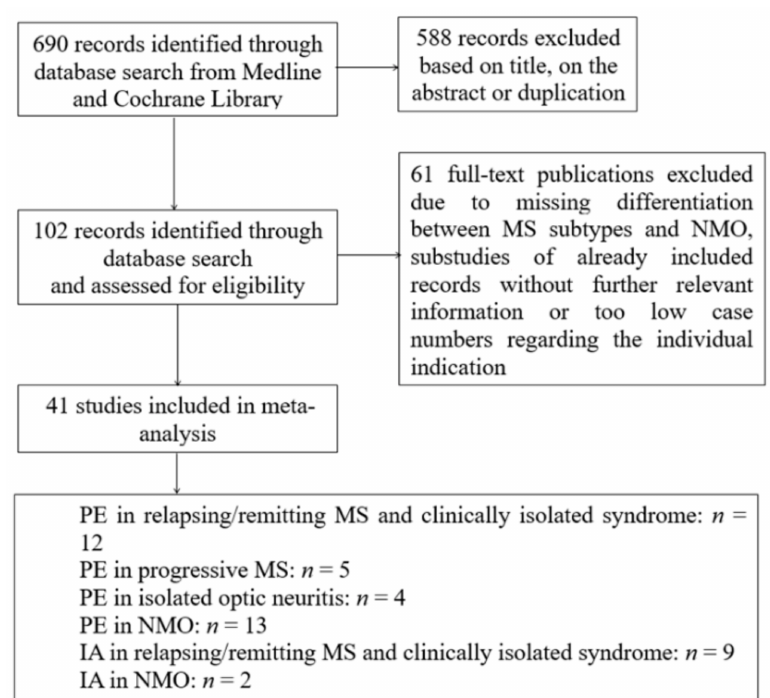
Figure 1. Flow chart of study selection. MS = multiple sclerosis, NMO = neuromyelitis optica, PE = plasma exchange, IA =